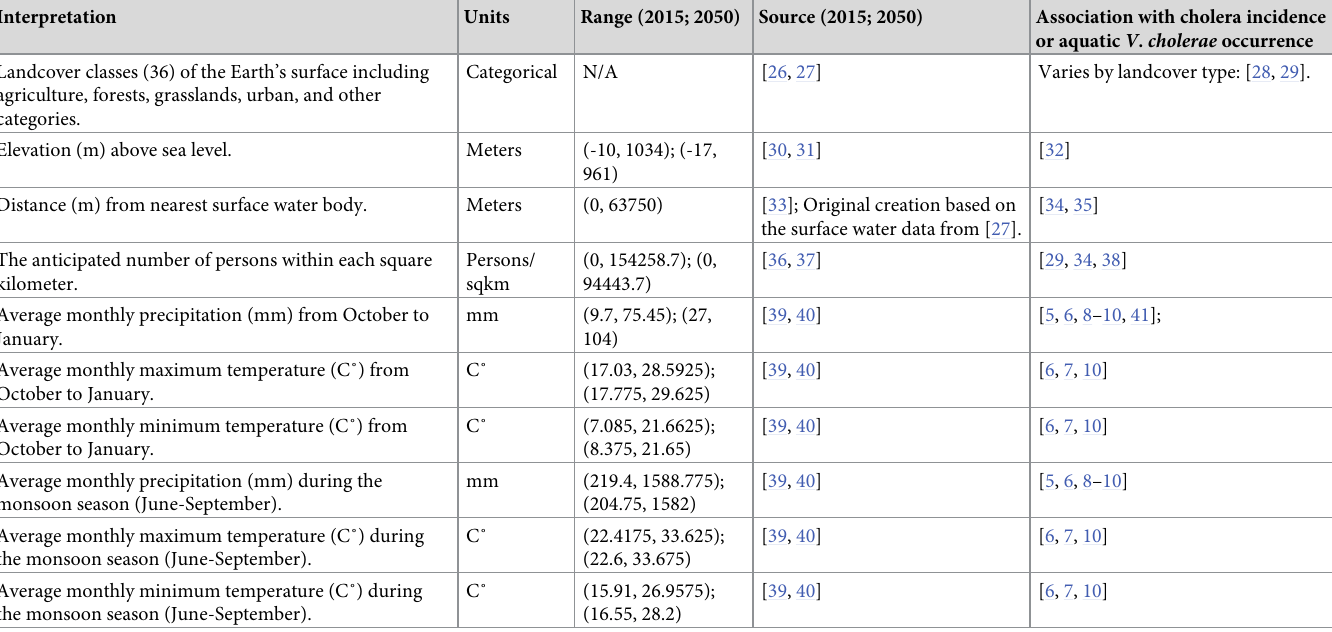
Table 1. Summary of considered environmental variables.